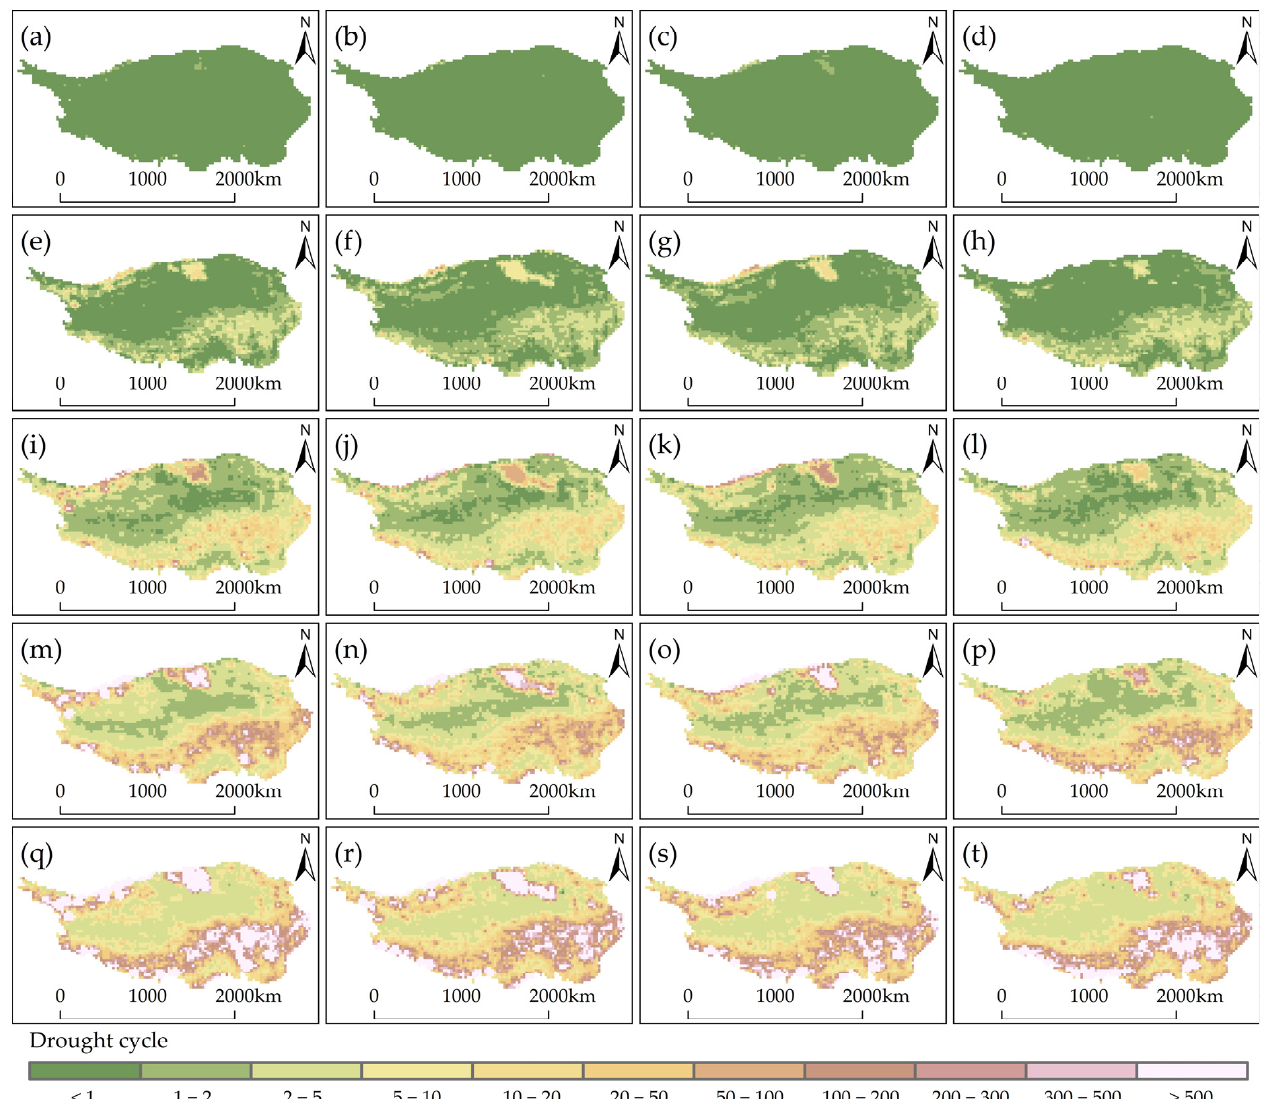
Figure 13. Distribution maps of the drought cycle of the TP for drought durations of 1 ‒ 5 months under four climatic scenarios: drought duration of 1 month under the ( a ) RCP2.6, ( b ) RCP4.5, ( c ) RCP6.0, and ( d ) RCP8.5 climate scenarios; drought duration of 2 months under ( e ) RCP2.6, ( f ) RCP4.5, ( g ) RCP6.0, and ( h ) RCP8.5; drought duration of 3 months under ( i ) RCP2.6, ( j ) RCP4.5, ( k ) RCP6.0, and ( l ) RCP8.5; drought duration of 4 months under ( m ) RCP2.6, ( n ) RCP4.5, ( o ) RCP6.0, and ( p ) RCP8.5; drought duration of 5 months under ( q ) RCP2.6, ( r ) RCP4.5, ( s ) RCP6.0, and ( t )